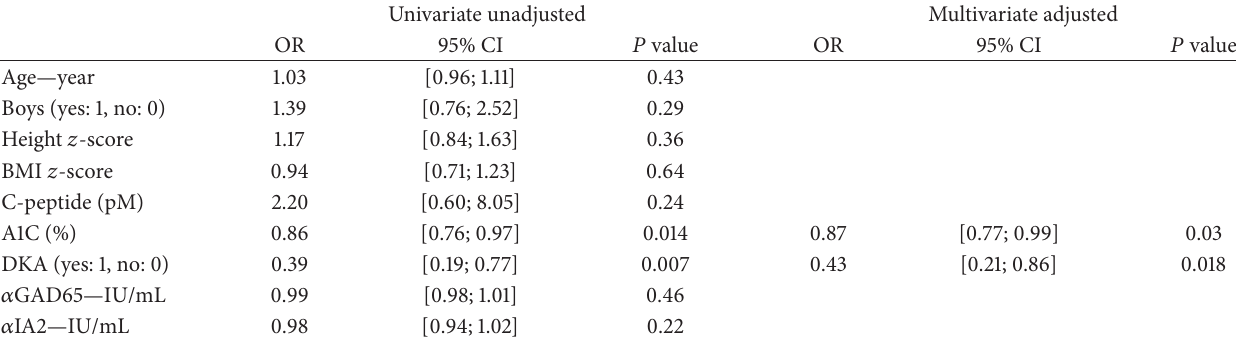
Table 3: Factors at diagnosis associated with PR, using multivariate logistic regression. Univariate unadjusted Multivariate